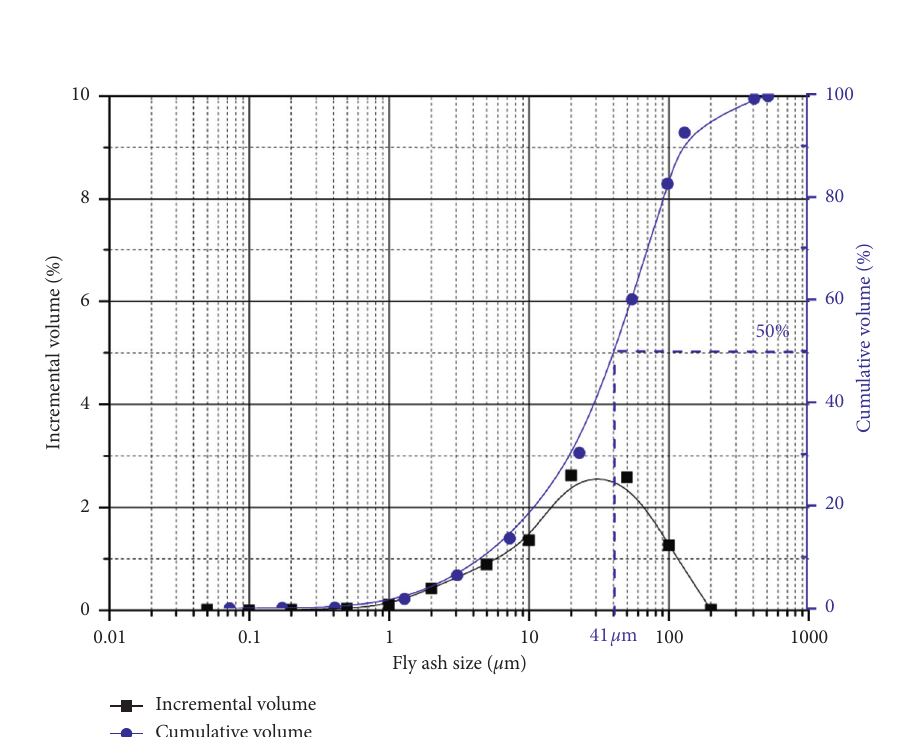
Figure 4: Particle size distribution of fly